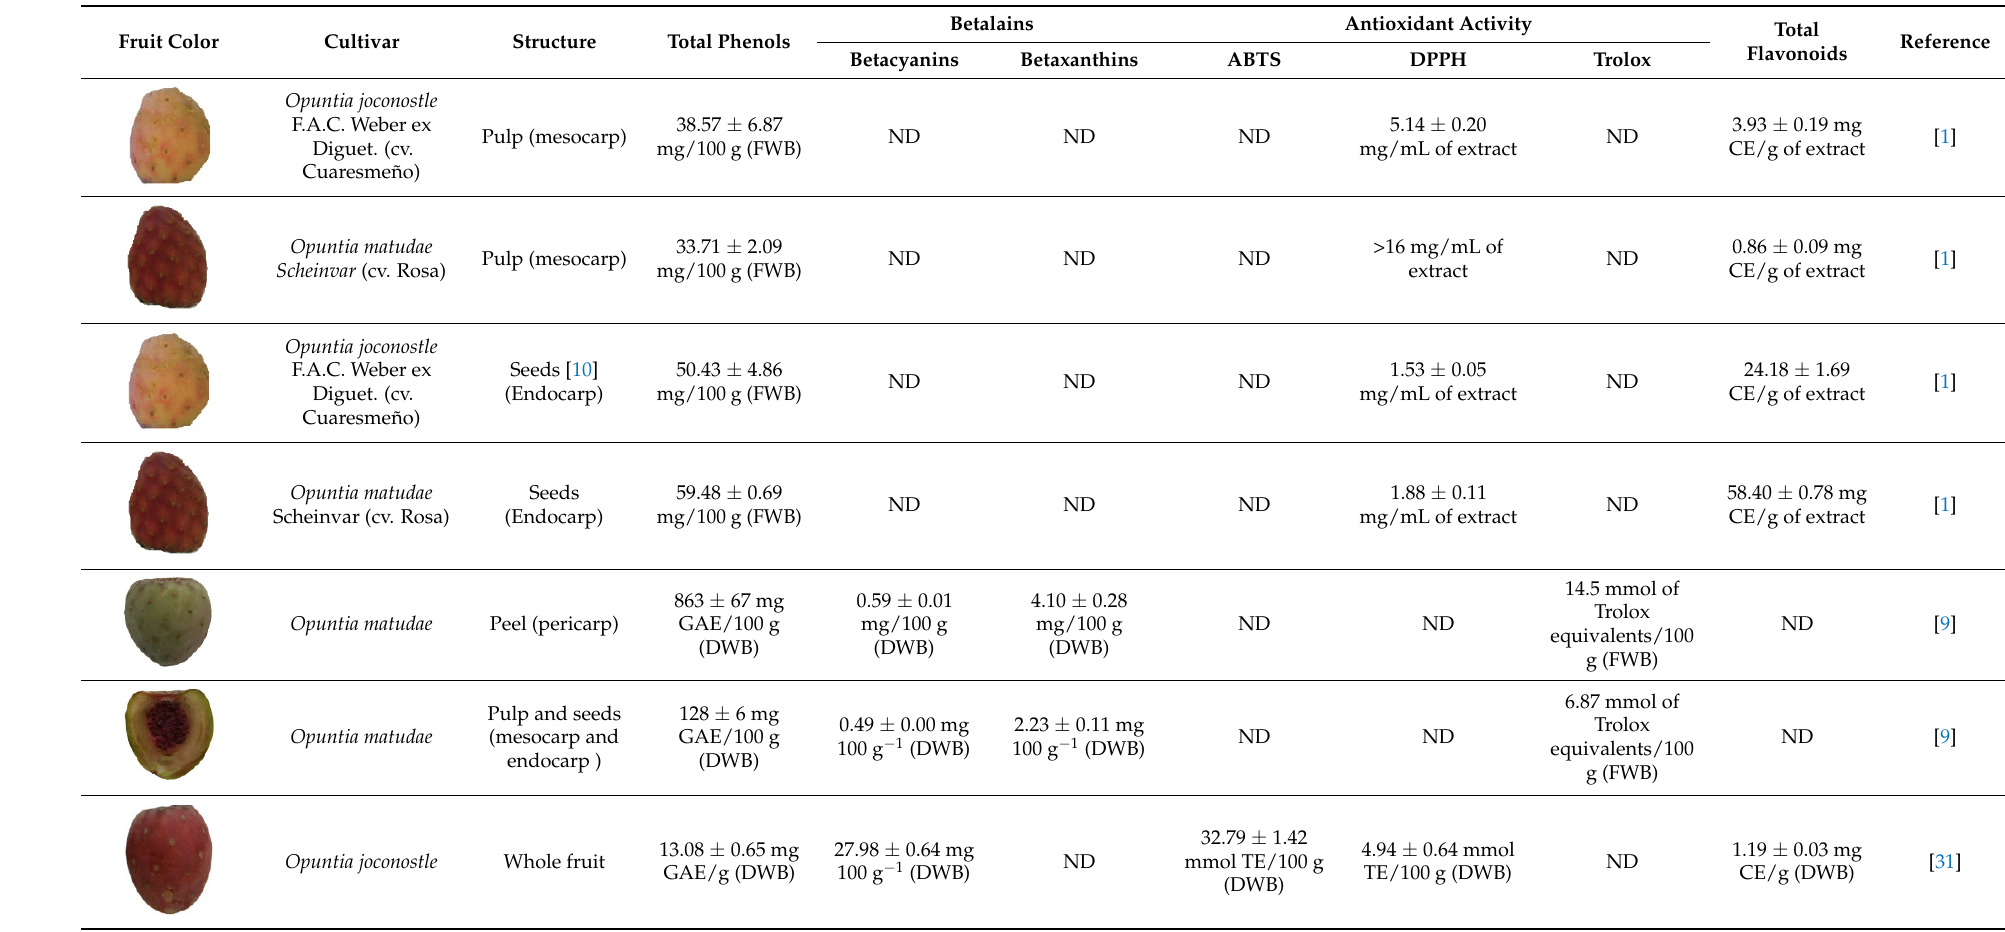
Table 2. Bioactive compounds in Opuntia spp. acid fruits.